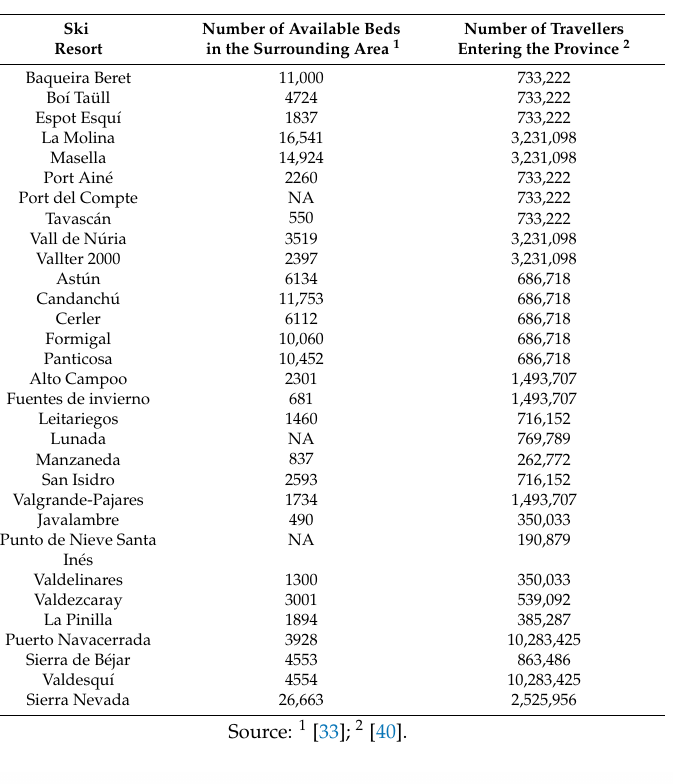
Table A3. Touristic offer and demand of the ski resorts.